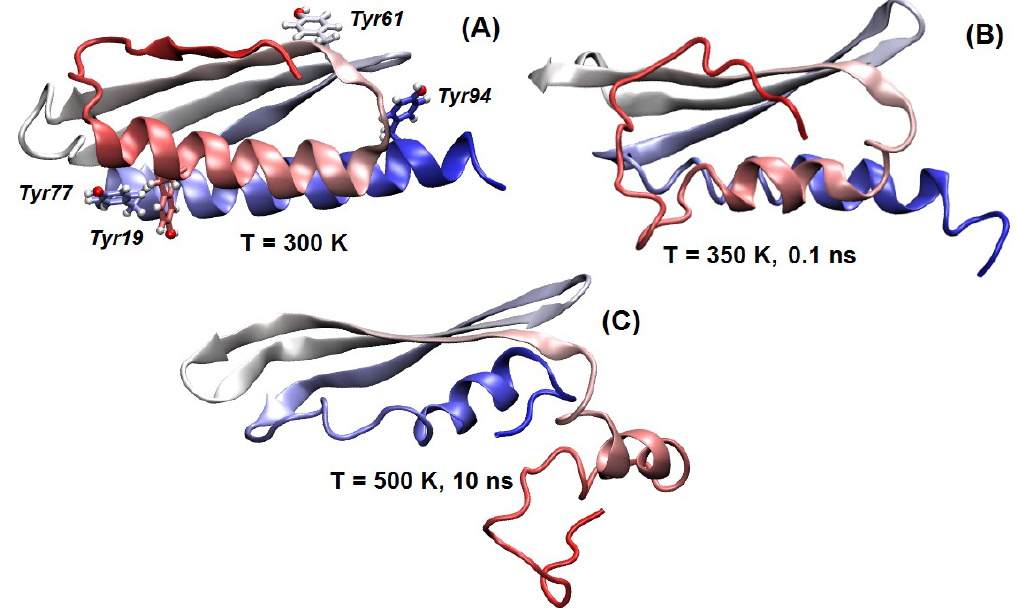
Figure 4. Dynamic behavior of the predicted folded domain of LrtA: The region comprising residues 1–100 of LrtA is shown in cartoon representation (colored from red (N terminus) to silver-white (mid-sequence regions) up to blue (C terminus of the domain)). ( A ) Structure at room temperature, with Tyr residues indicated. ( B ) Simulation under unfolding conditions: in the N-terminal region (indicated in red), the first β-strand loses it structure and coordination with the rest of the β-sheet. ( C ) Structure under extreme conditions: the folding topology is maintained. VMD [40] is used for the protein displays.